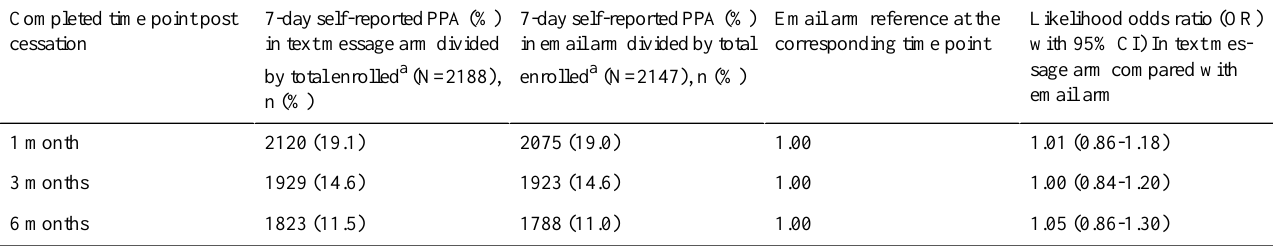
Table 3. Seven-day self-reported point prevalence abstinence (PPA), among enrolled smokers who had completed the 1-, 3-, and 6-month post cessation time point by arm and the corresponding likelihood odds ratio (95% CI) comparing the text message arm with the email arm.